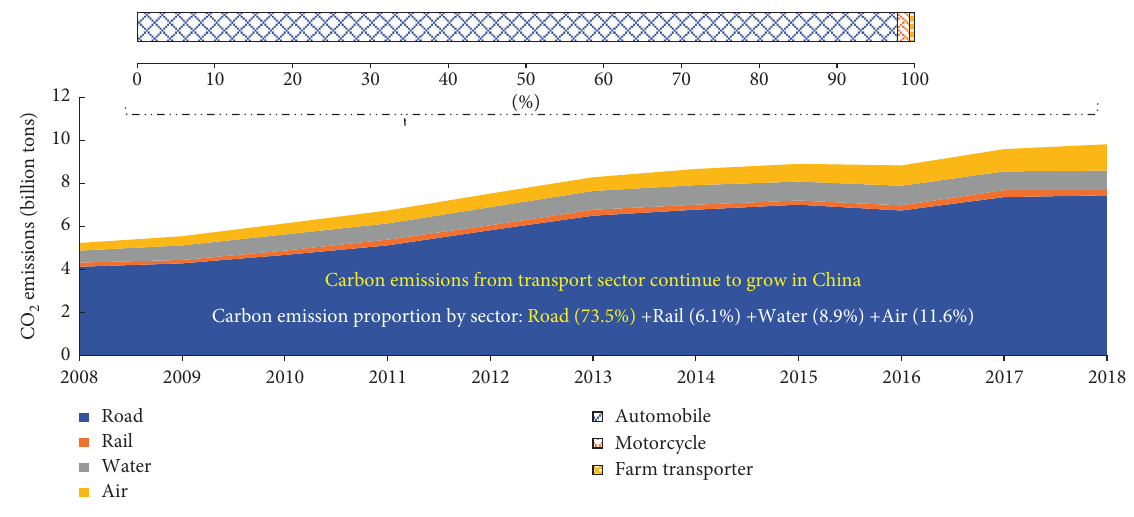
Figure 1: Carbon emission of the road transport sector and automobile industry [5, 6] (note: the carbon emissions of the automobile industry account for about 97.8% of the road transport sector in